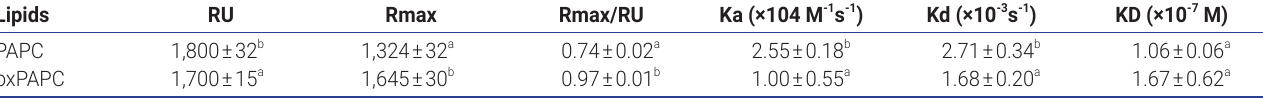
Table 1. Binding of Hsp90 to various compositions of liposome as analyzed by surface plasmon resonance